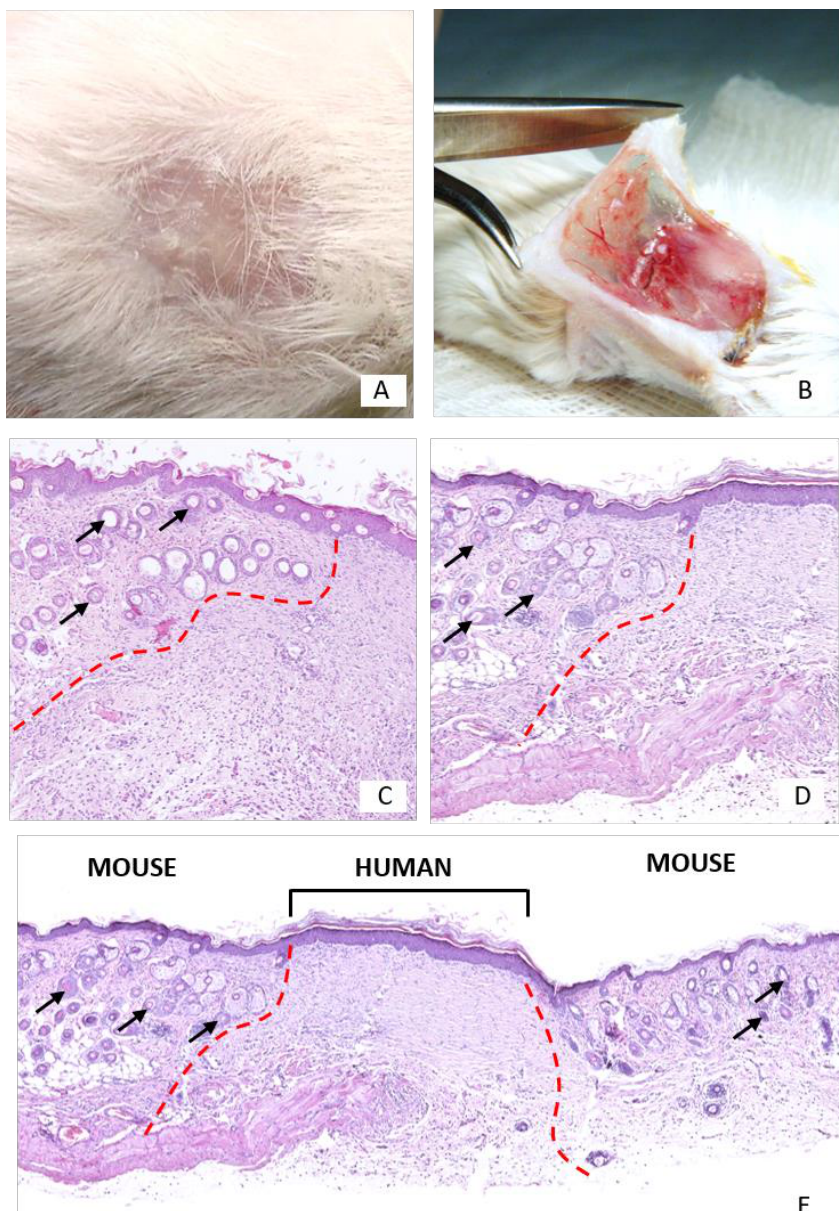
Figure 5. ( A , B )—Keratinocytes preserved for 3 months and transplanted for 21 days. ( A )—A completely healed wound, ( B )—Full blood supply to the graft bed. ( C – E )—Histologic picture of newly formed epidermis originated from transplanted human keratinocytes isolated from fresh skin ( C ) and skin preserved in anhydrous NaCl for 3 months ( D , E ). The border between the human and mouse epidermis is marked with a red line. The human dermis lacks the hair follicles characteristic of the mouse dermis (arrows). Slides stained with hematoxylin-eosin, magnification 10 × ( C , D ) and 5 × ( E ).